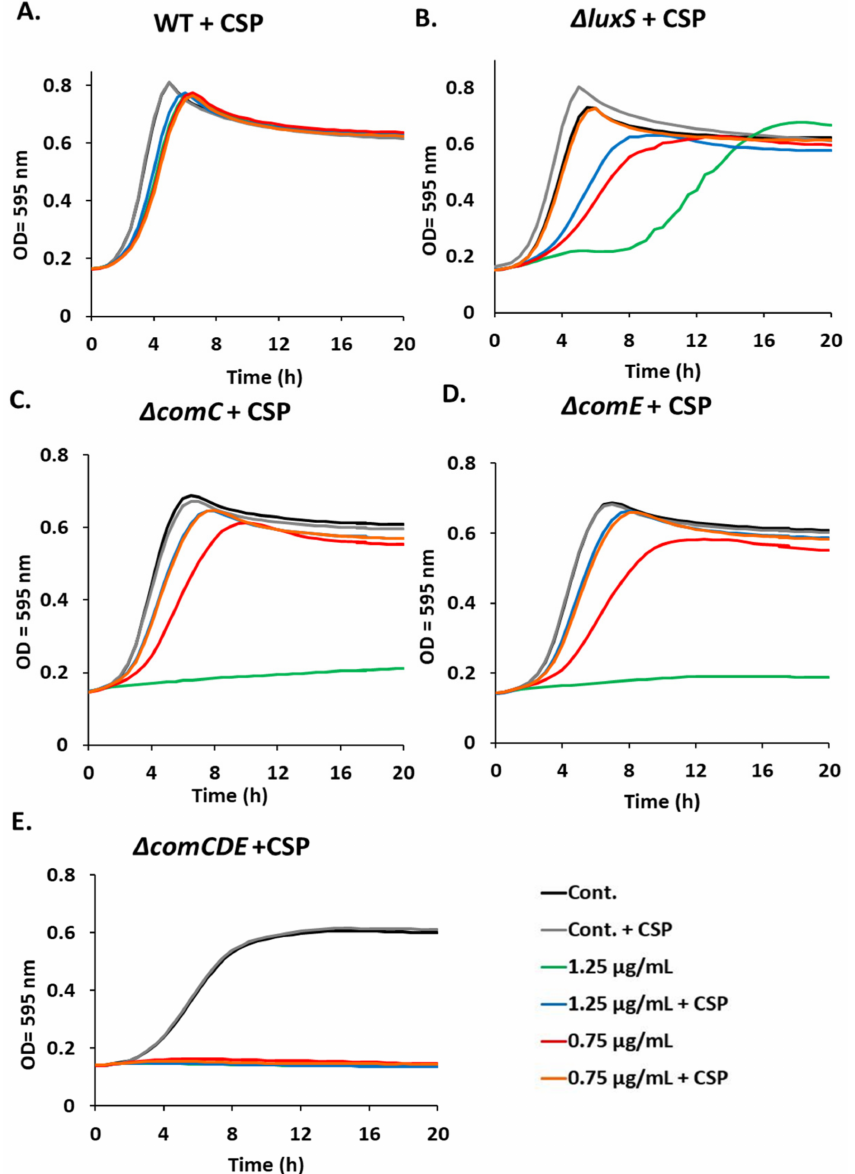
Figure 2. 21-CSP prevented the anti-bacterial effect of CBG on the ∆ comC and ∆ comE strains. ( A – E ). Kinetic studies of the planktonic growth of the various S. mutans strains incubated in the absence or presence of CBG (1.25 µ g/mL) and/or 21-CSP (1 µ g/mL) with an initial OD 600nm of 0.1. ( A ). WT; ( B ). ∆ luxS ; ( C ). ∆ comC ; ( D ). ∆ comE ; and ( E ). ∆ comCDE . n =